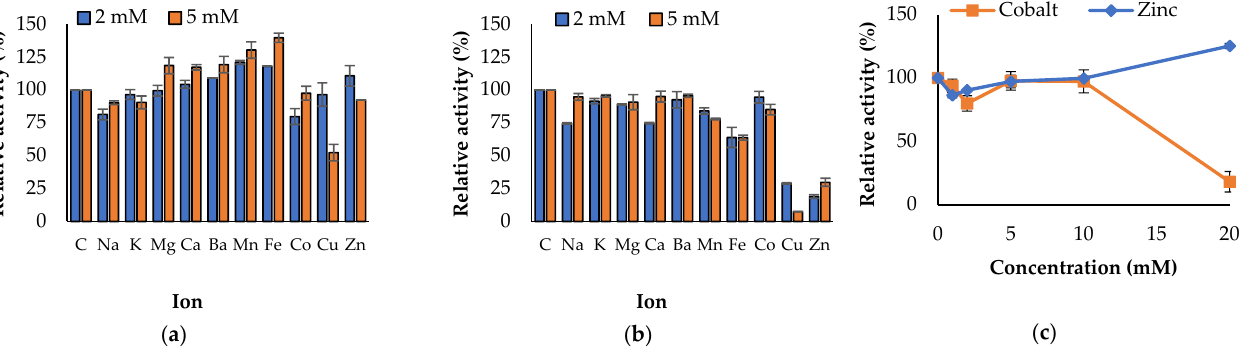
Figure 10. Effects of cations on the activities of Est2L ( a ) and Est4L ( b ) and of Co 2+ and Zn 2+ ions on Est2L activity ( c ). Control is the enzyme activity in the absence of metal ions. Ethylenediaminetetraacetic acid (EDTA) showed insignificant effects on Est2L and Est4L, which retained relative activities of 96.6% and 88.6% respectively. To observe the effects of EDTA and metal ion combinations, EDTA was preincubated and then metal ions were added, or vice versa, for Est2L and Est4L. In the experiments, little difference was observed as a result of change of preincubation order, except that inhibition by EDTA -> Cu 2+ was greater than that by Cu 2+ -> EDTA and inhibition by the combination of EDTA and Co 2+ was greater than those of isolated EDTA or Co 2+ in Est2L (Figure 11). It is possible that the bindings of Cu 2+ or Co 2+ and EDTA to Est2L were more complex than to Est4L. For the lipid hydrolysis activities, Est2L and Est4L hydrolyzed glyceryl tributyrate to 69.0% and 52.8% respectively, followed by trioctanoate to 77.9% and 71.9% respectively (Figure 12). It was confirmed that the hydrolyzing activities of fish oil, olive oil, and glyceryl trioleate by Est2L and Est4L were remarkably low. When based on glyceryl tributyrate as a substrate, Est4L showed a 25.1% higher hydrolyzing activity than Est2L.